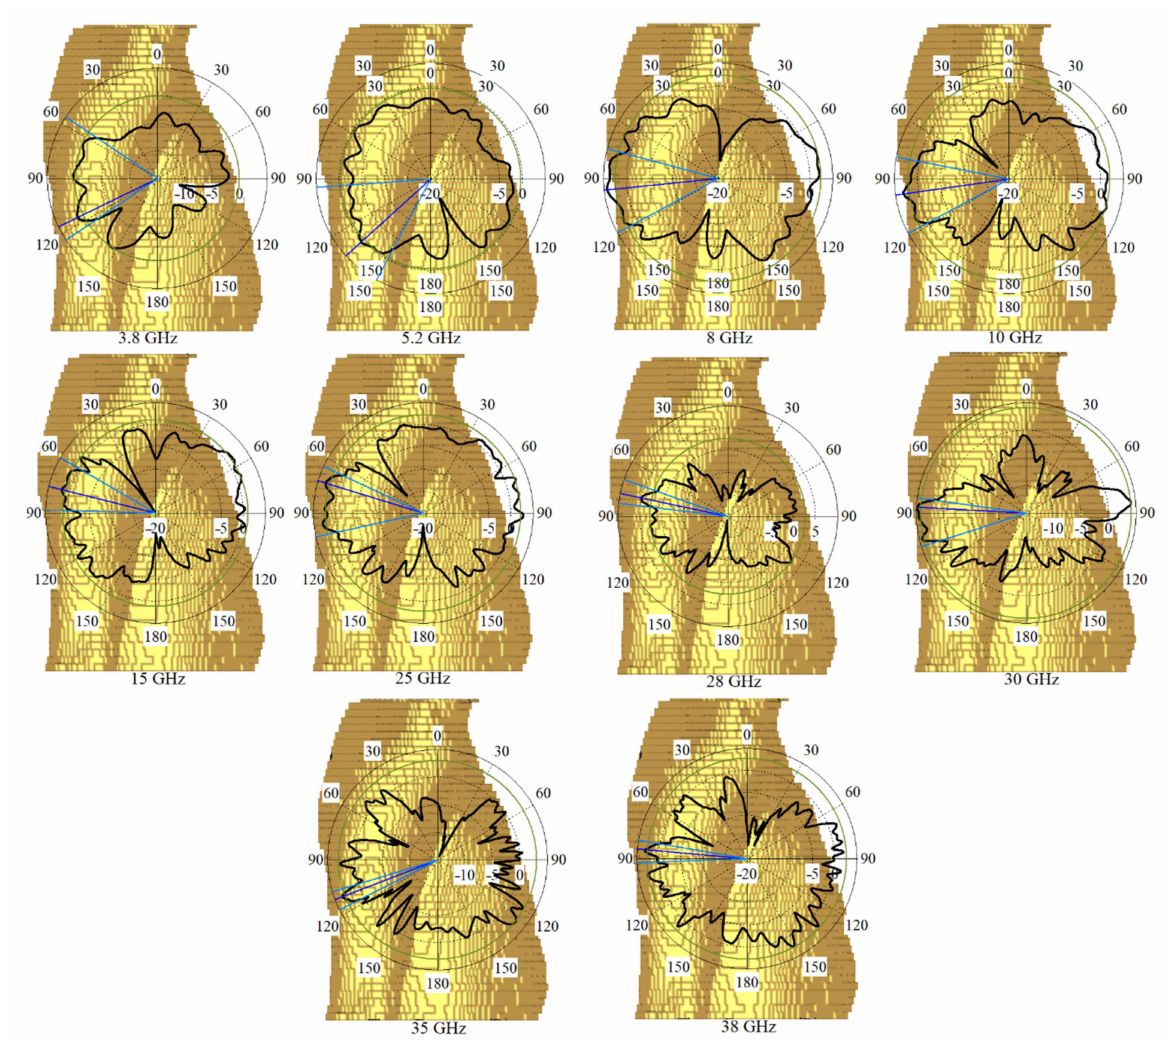
Figure 30. The simulated radiation pattern of the proposed MIMO antenna on arm of voxel body at different